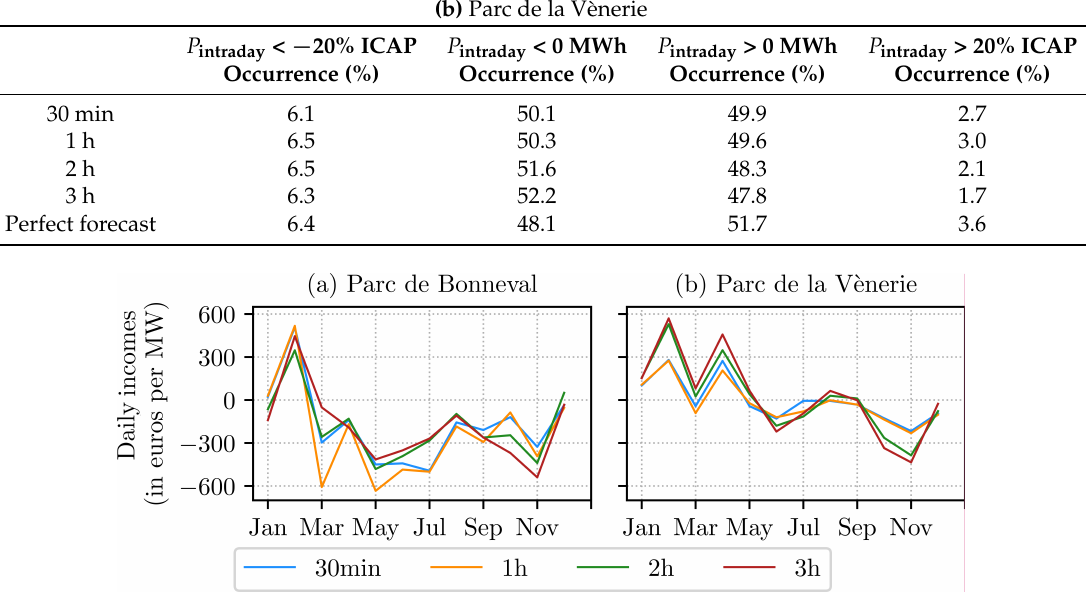
Figure 9. Daily income from imbalance averaged over months at Parc de Bonneval in 2015 ( a ) and at Parc de la Vènerie ( b ) in 2015 for four different balancing strategies (30 min, 1 h, 2 h and 3 h before the delivery